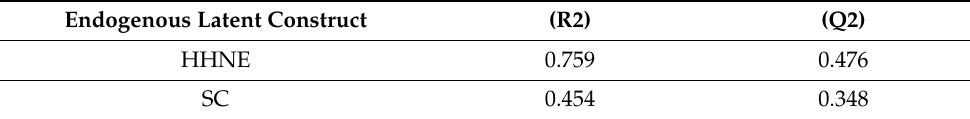
Table 4. R2 and Q2 Coefficient of determination.